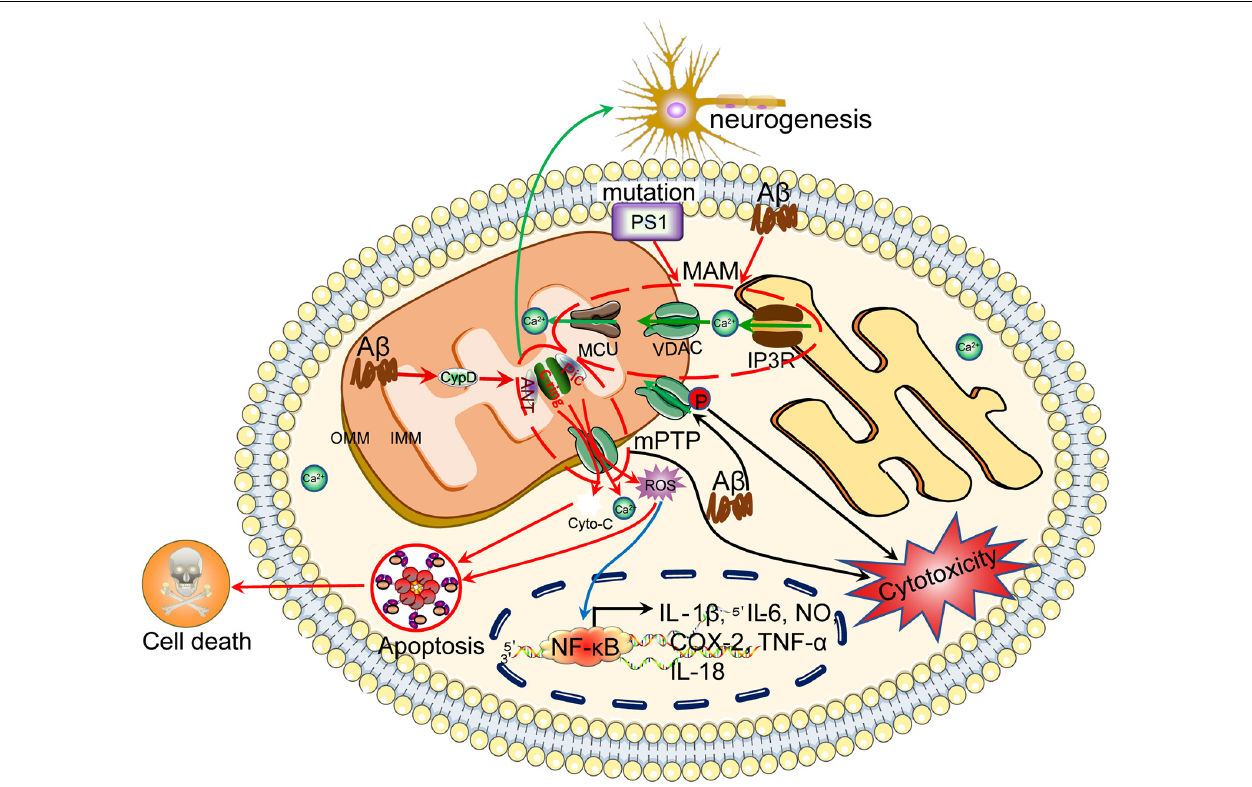
FIGURE 3 | Ca 2+ efflux from mitochondria regulates the apoptosis of neuronal cells, which results in cognitive dysfunction. Ca 2+ is transported to the mitochondria via MCU. Under physiological or pathological conditions, Ca 2+ is continuously shuffled between the ER and mitochondria via VDAC. Moreover, Ca 2+ in mitochondria induces the formation of the mPTP, which transports Ca 2+ and small molecules, such as ROS and cytochrome C, from the mitochondria to the cytosol, leading to neuronal apoptosis. The loss of neurons will cause cognitive